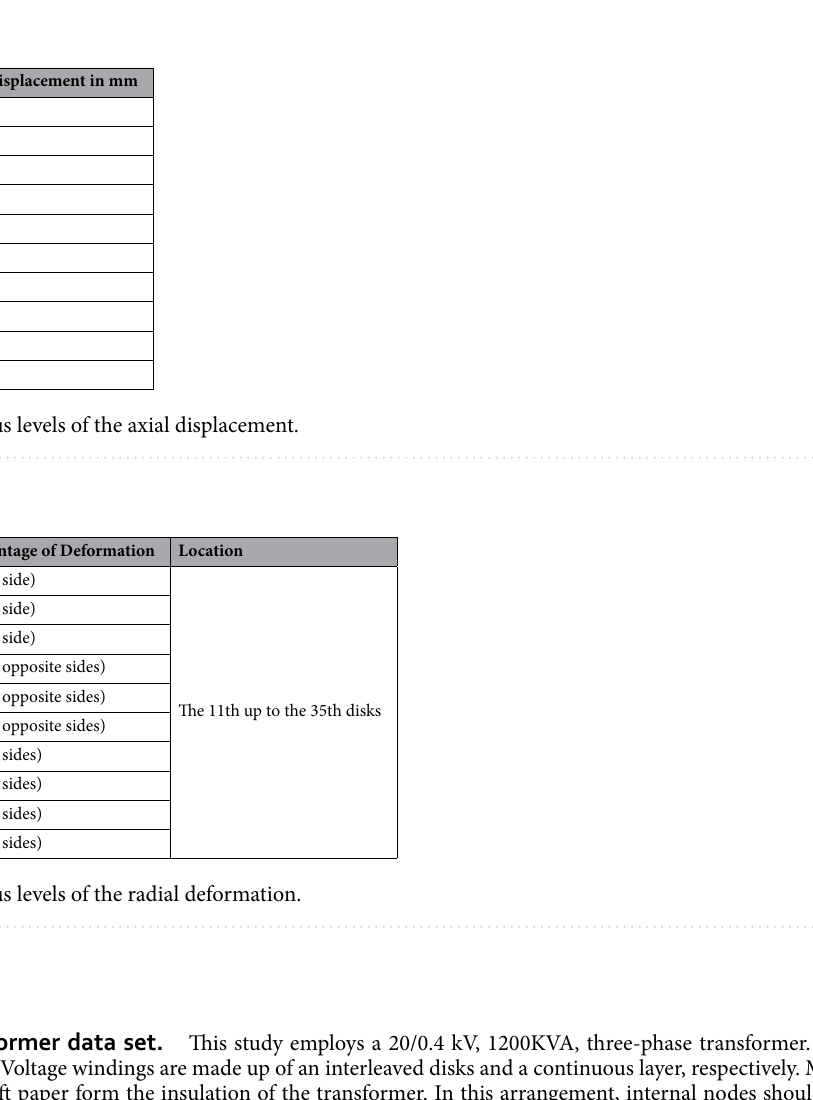
Table 1. Different short circuit levels at various locations.